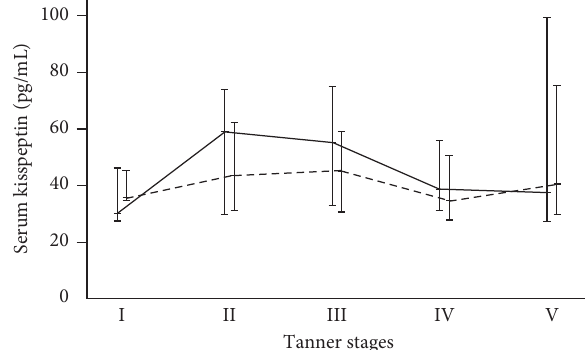
Figure 1: Serum kisspeptin levels across 5 genital Tanner stages in boys ( N � 127) and 5 breast Tanner stages in girls ( N � 143) ( p � 0 . 034 for boys and 0.730 for girls). Error bars represent median (horizontal line) and interquartile range (bar); the solid line represents boys; and the dashed line represents